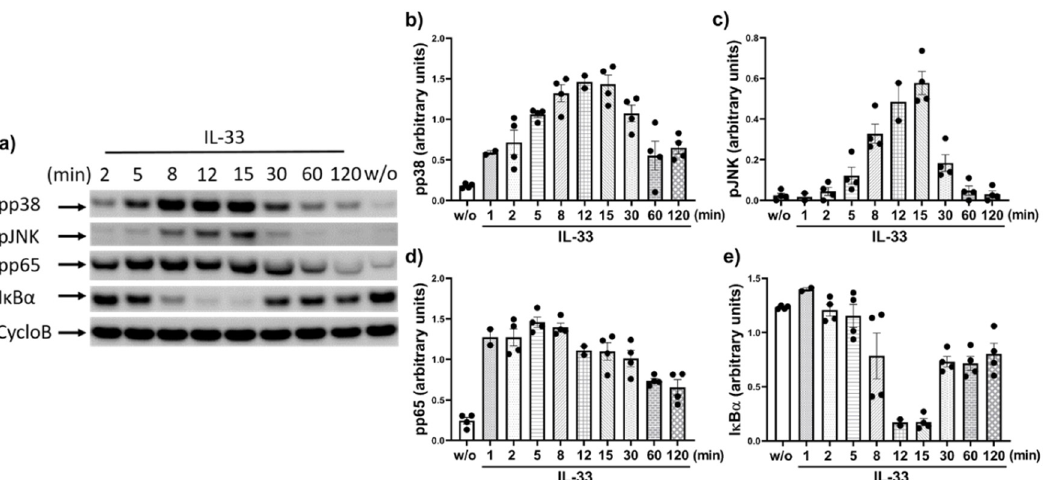
Figure 2. IL-33 elicits pp38, pJKN, pp65, and I κ B degradation in human skin MCs. MCs were treated with IL-33 for the times given and the phosphorylation of kinases and components of the canonical NF- κ B pathway were detected by immunoblot. ( a ) Representative time-course. ( b – e ) Image J based the semi-quantification of the detected signals for pp38 ( b ), pJNK ( c ), pp65 ( d ), and I κ B α ( e ). Each dot represents an independent MC preparation. Data are presented as mean ± SEM of up to four experiments for each time point (arbitrary units, calculated as explained in Methods). CycloB = cyclophilin B (loading control).